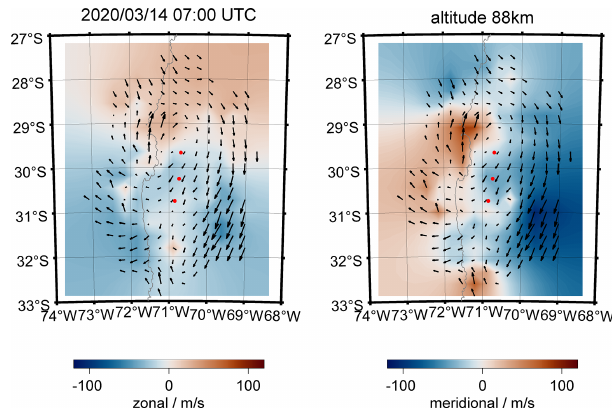
Figure 9. The two panels present color-coded 3D-Var retrievals of zonal and meridional winds. The black arrows highlight a large vor- tex above the Andes observed on 14 March